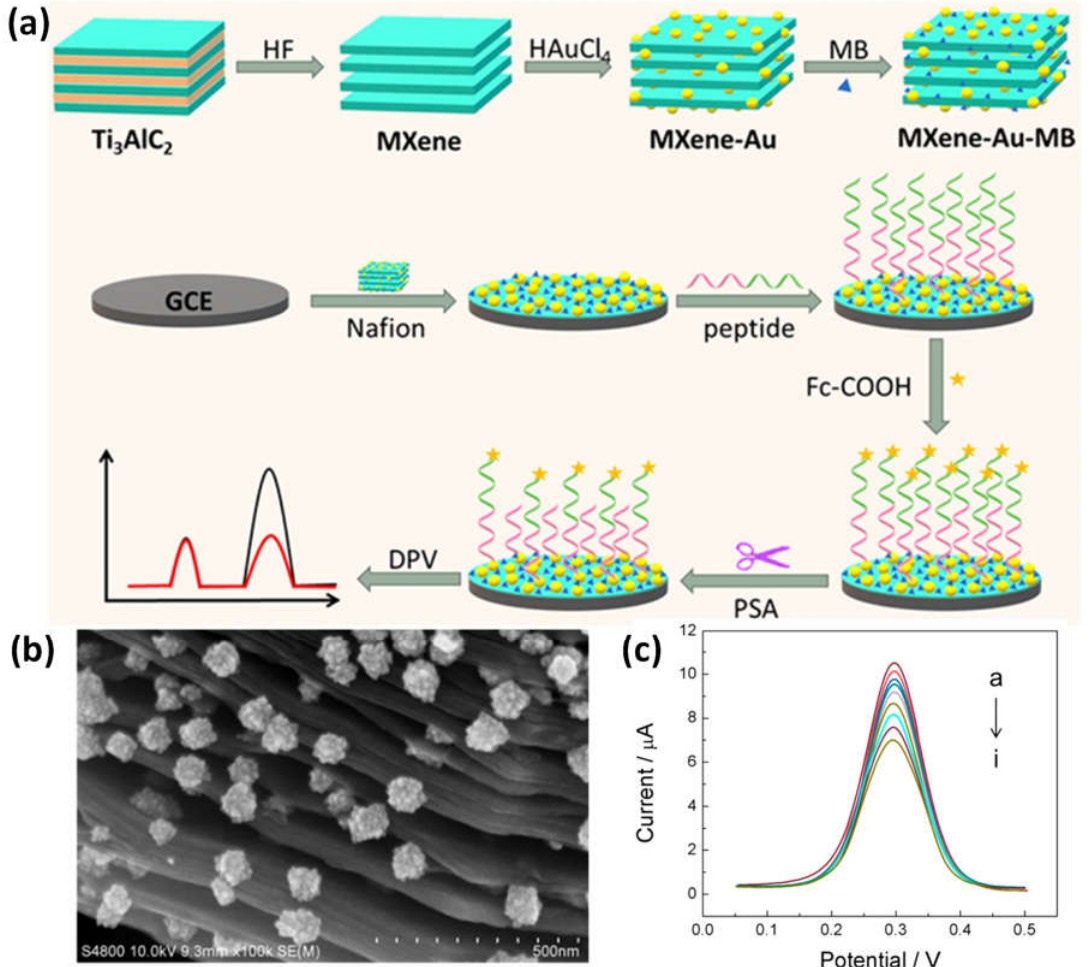
Figure 8. Diagrammatic representation of the operation of a ratiometric antifouling electrochemical biosensor is indicated in ( a ), along with ( b ) SEM pictures of a composite made of MXene and Au at various magnifications and ( c ) a sensor interface that reacts to PSA’s DPV signal without a standard solution. Reproduced with permission from reference [86].